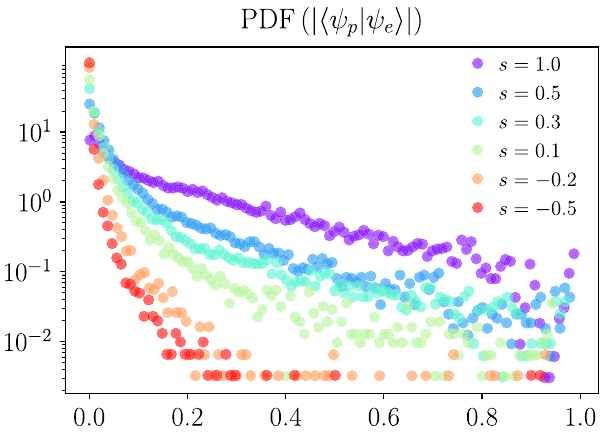
FIG. 11. Probability density function of the estimated maximal overlap with a product state. For negative values of s , most of the eigenstates have a small overlap with product states. For positive values of s , the distribution develops long tails: Many eigenstates have considerably large overlap with product states. Data are shown for N ¼ 15 .